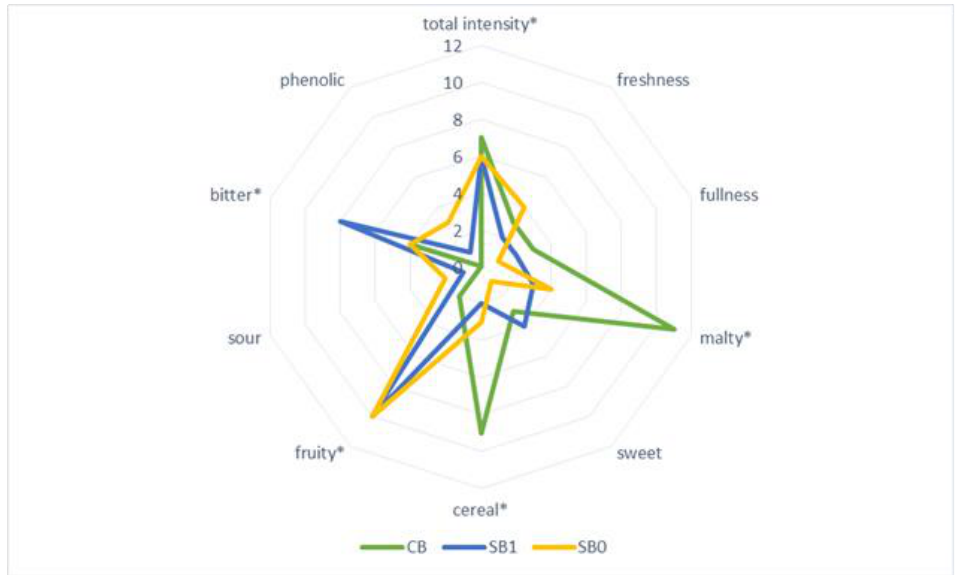
Figure 5. Sensory profile of barley beers —control (CB) and sample with addition of ‘Smoky’ cultivar fruit untreated (SB1) and treated with ozone (SB0); * marks the attributes which were statistically different at p ≤ 0.05.